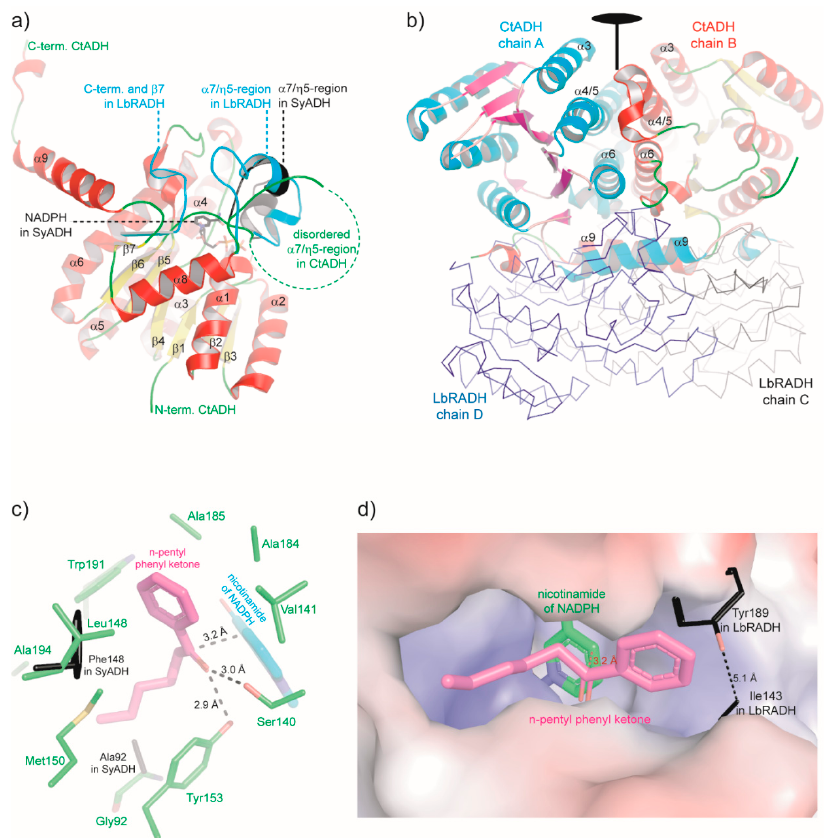
Figure 3. Structure of CtADH. ( a ) Overview of a CtADH monomer with secondary structure elements labelled according to the sequence alignment in Figure 1. For comparison, parts of the structures of the SyADH/NADPH complex (PDB ‐ ID 4BMV [26]) and of apo ‐ LbRADH (PDB ‐ ID 1NXQ [22]) were depicted after structural overlay on CtADH. ( b ) Dimerization of CtADH via a central four ‐ helix bundle ( α 4/5 plus α 6), assisted by the non ‐ canonical helices α 9, from both subunits. To illustrate how the helix α 9 couple blocks the tetramerization surface of typical tetrameric SDR enzymes, two subunits of the LbRADH tetramer [22] were drawn after superimposition of the other two subunits (not shown) on the CtADH dimer. ( c ) Active site region of an in ‐ silico model of CtADH in complex with NADPH and the substrate n ‐ pentyl phenyl ketone. Two side chains of SyADH different from CtADH were drawn with black C ‐ atoms after structural overlay of the proteins. ( d ) Substrate ‐ binding tunnel of CtADH occupied with n ‐ pentyl phenyl ketone (in ‐ silico model). To illustrate the generous space supply in the outer part of the substrate ‐ binding tunnel of CtADH, two LbRADH side chains were drawn (black C ‐ atoms) that restrict the space in this region of LbRADH significantly.